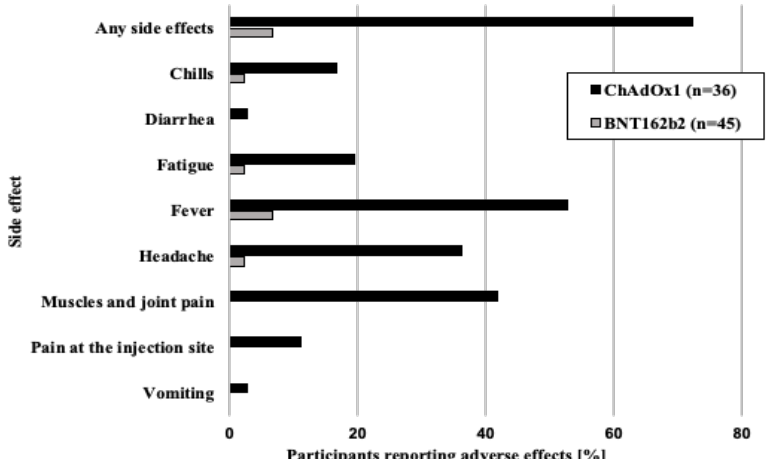
Figure 2. Side effects after the two doses of BNT62b2 or ChAdOx1 vaccine. Participants could report more than one side effect.